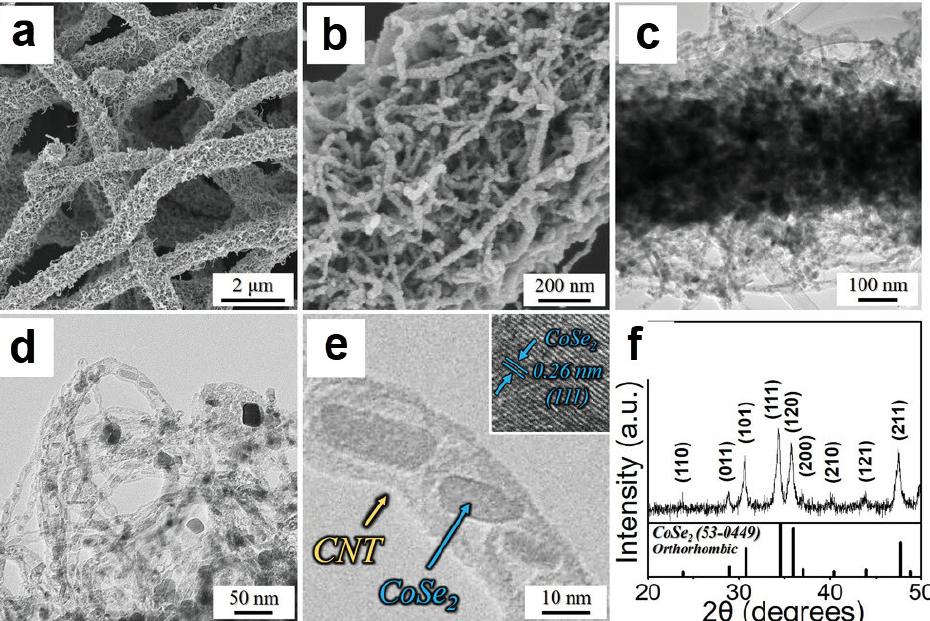
Figure 14. The SEM and TEM morphology and XRD characterization of N-CNT/rGO/CoSe 2 NF: ( a ) and ( b ) FE-SEM images with different magnifications, ( c – e ) HR-TEM images with different magnifications, ( f ) XRD pattern. Reproduced with permission [90]. Copyright 2019, Wiley-VCH.